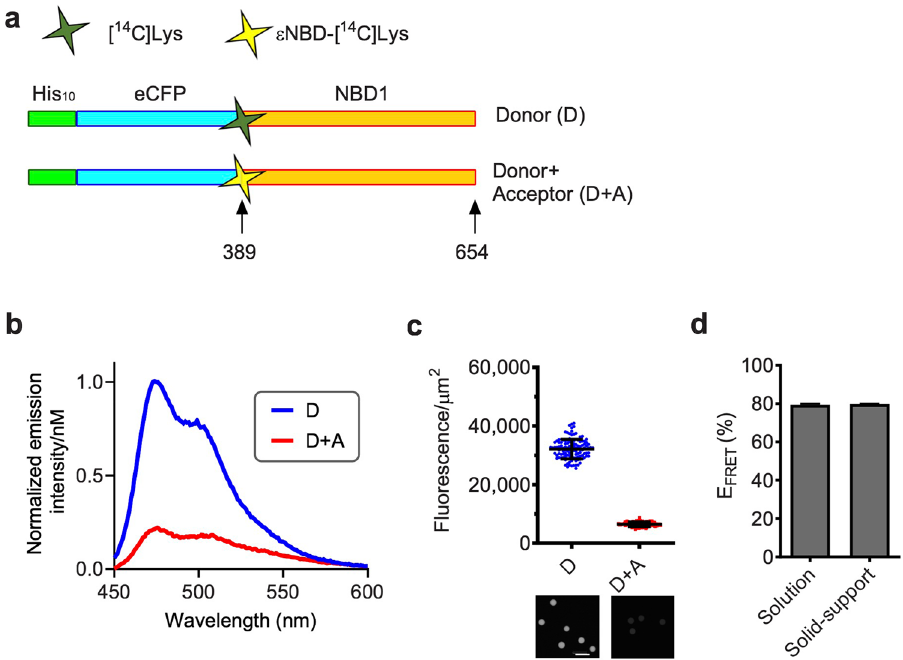
Figure 3. Solution FRET and Solid-support FRET of immobilized RNCs. ( a ) Schematic of His 10- CFP-NBD1 construct showing approximate location of acceptor dye residue (389) and truncation site residue (654). ( b ) Graph showing CFP fluorescence emission spectra in solution in D and D + A samples. ( c ) Graph showing fluorescence intensity of 17 µm beads (mean ± SD, n = 118 or 108 for D or D + A beads, respectively). Raw images of beads containing D or D + A RNCs is shown below graph. Scale bar, 50 µm. ( d ) Graph showing Solution E FRET and Solid-support